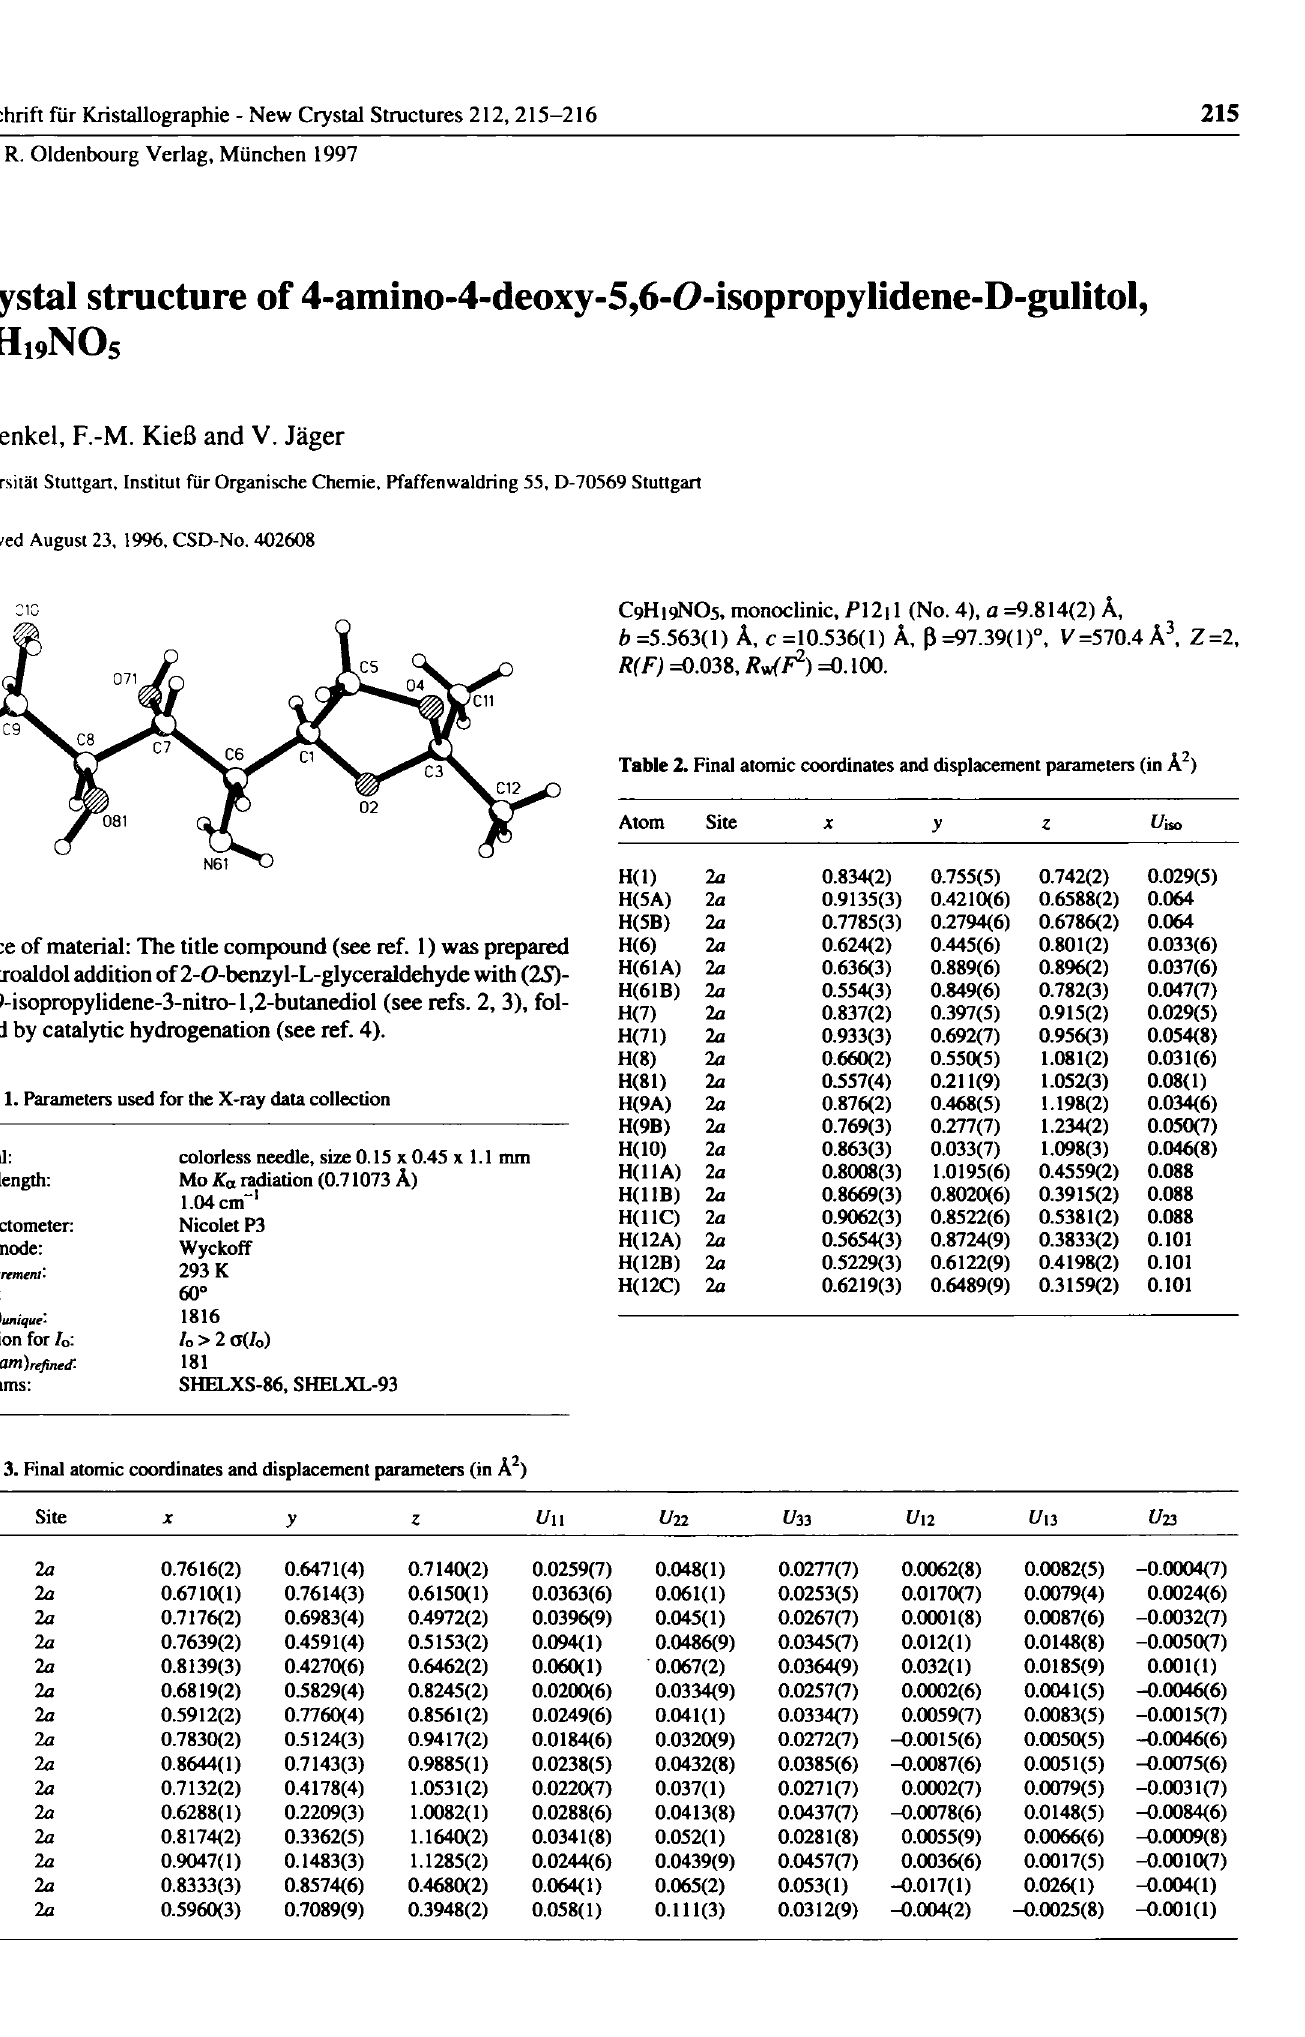
Table 1. Parameters used for the X-ray data collection